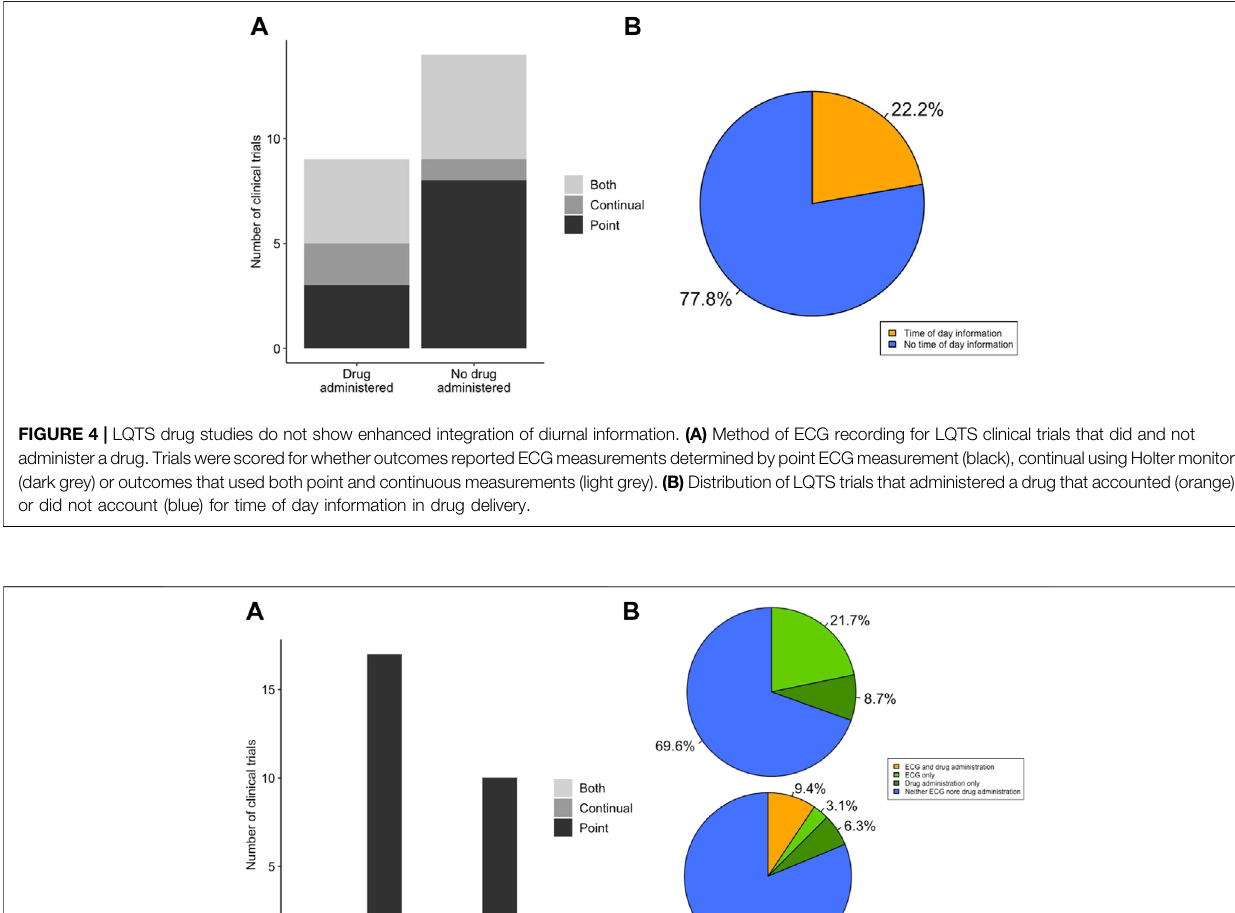
Frontiers in Pharmacology |